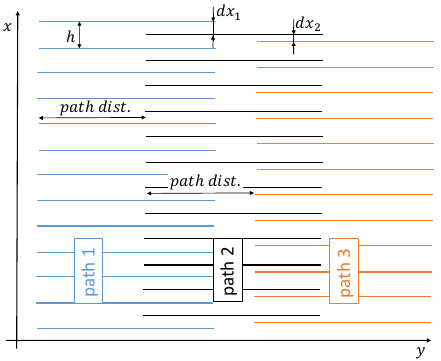
Figure 3. Normalized depiction of the spiraling movement of the irregularities on the ADAPT tool surface